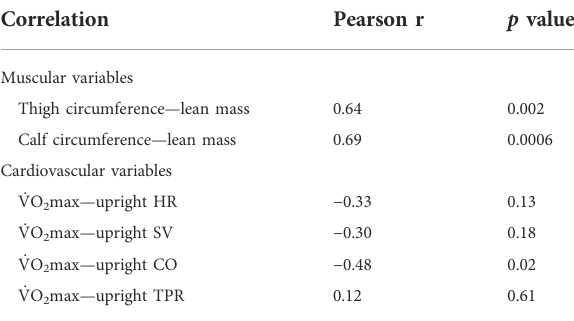
TABLE 3 Correlations between percent changes in muscular and cardiovascular variables.